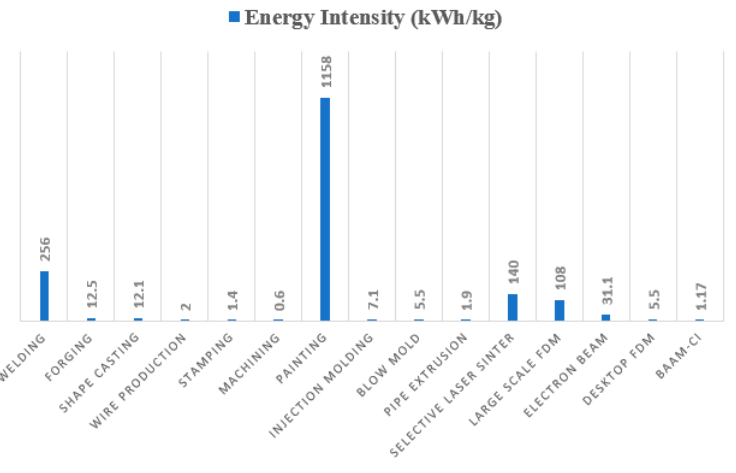
Figure 2. Energy requested for different manufacturing processes—reprinted from [5].